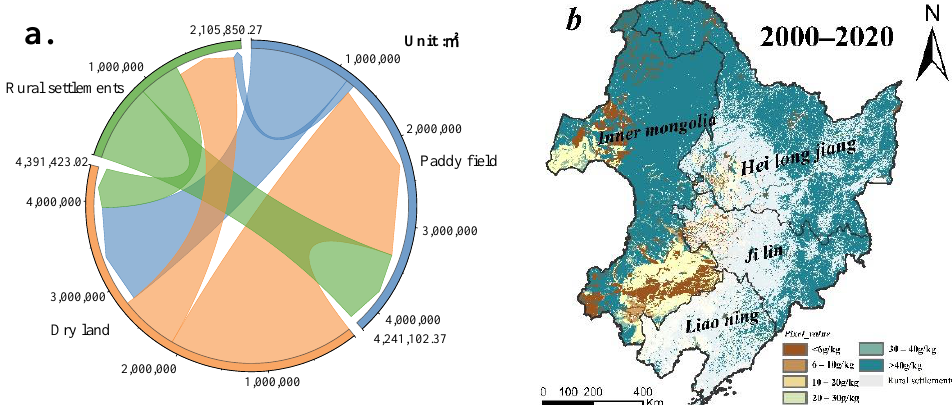
Figure 5. Characteristics of conversion of rural settlements and cultivated land: ( a ) dynamics of conversion of rural settlements and cultivated land area; ( b ) characteristics of cultivated land occupied by the expansion of rural settlements.